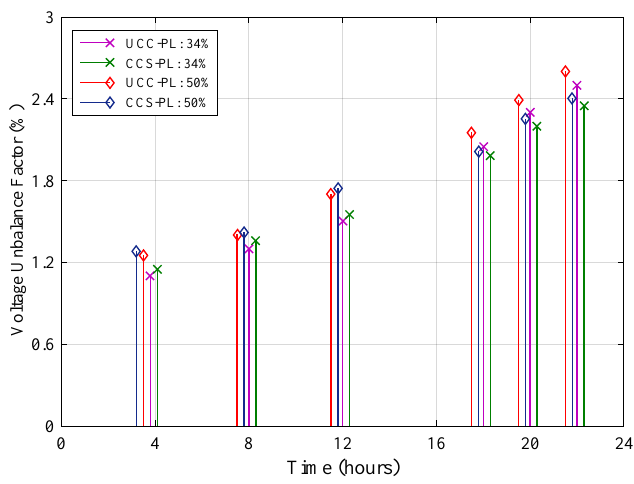
Figure 14. Voltage unbalances (%) at a load bus R15 in